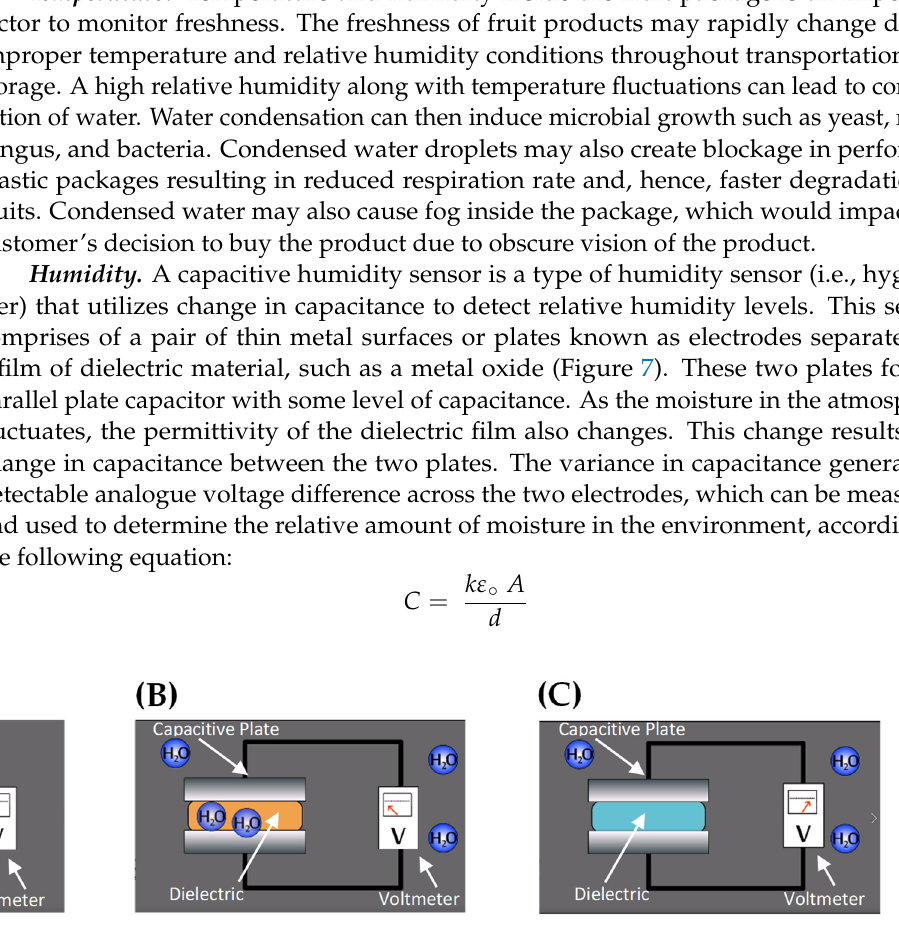
Figure 7. Working principle for a capacitive humidity sensor. ( A ) The initial setup of the capacitive sensor indicating no detectable voltage across the plates. ( B ) The introduction of water vapor in the atmosphere. ( C ) The change in the permittivity of the dielectric because of the water vapor, generating a detectable voltage across the plates.